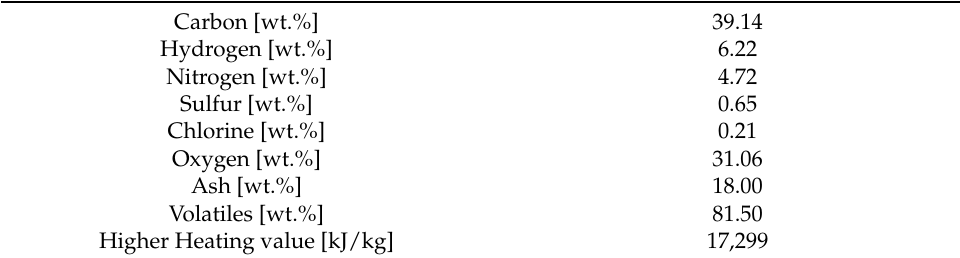
Table 2. Chemical properties of sewage sludge.